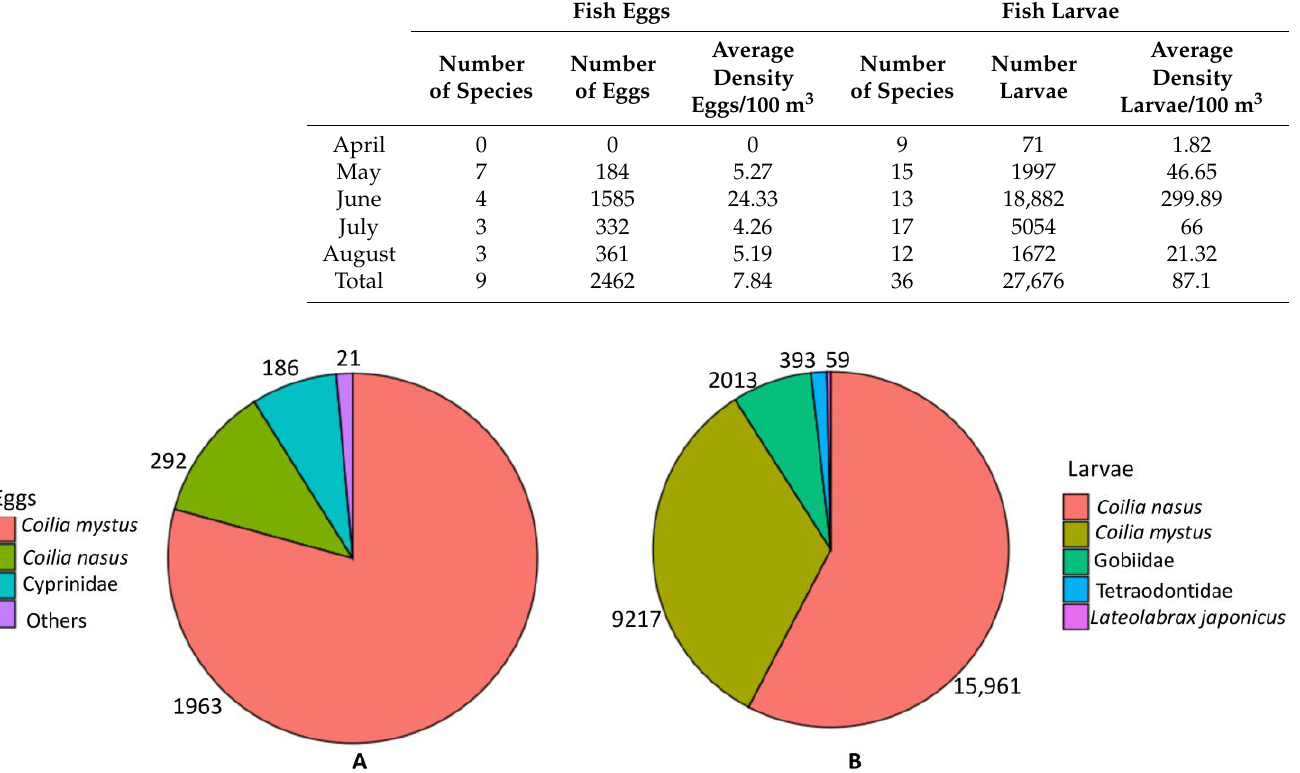
Figure 1. Number of dominant fish groups in Oujiang River Estuary. ( A ) Fish egg s and ( B ) fish